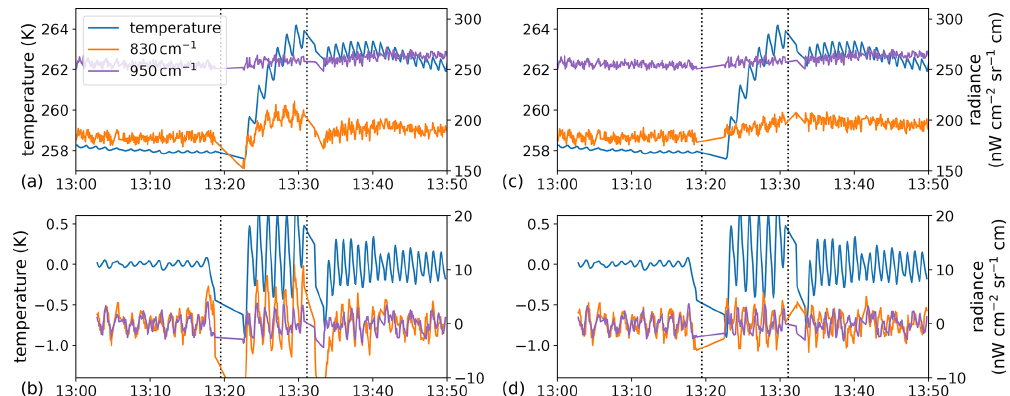
Figure 7. Averaged radiances for part of flight 13 of the WISE campaign during a tomographic measurement pattern for (a, b) original and (c, d) corrected radiances. The outer window temperature is shown in blue. Shown in orange and purple are the radiances for the central wavenumbers 830 and 950cm − 1 , each averaged over six wavenumbers and over rows 68 to 72 (except for the pixels flagged as faulty). The calibration measurement times are indicated by vertical dotted lines. Panel (a) : radiance values without window correction. Panel (b) : only the high-frequency part of the signal. Panels (c) and (d) show the same radiances as in (a) and (b) , respectively, but with window correction enabled.